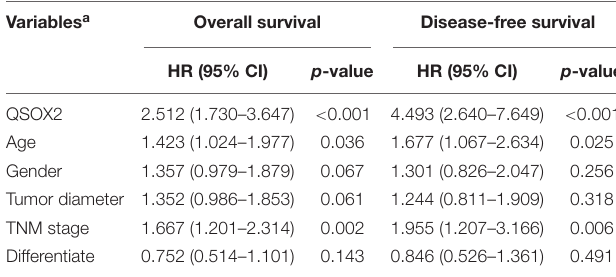
TABLE 8 | Multivariate Cox regression analysis on OS and DFS in CRC based on clinical specimen cohort. Variables a Overall survival Disease-free